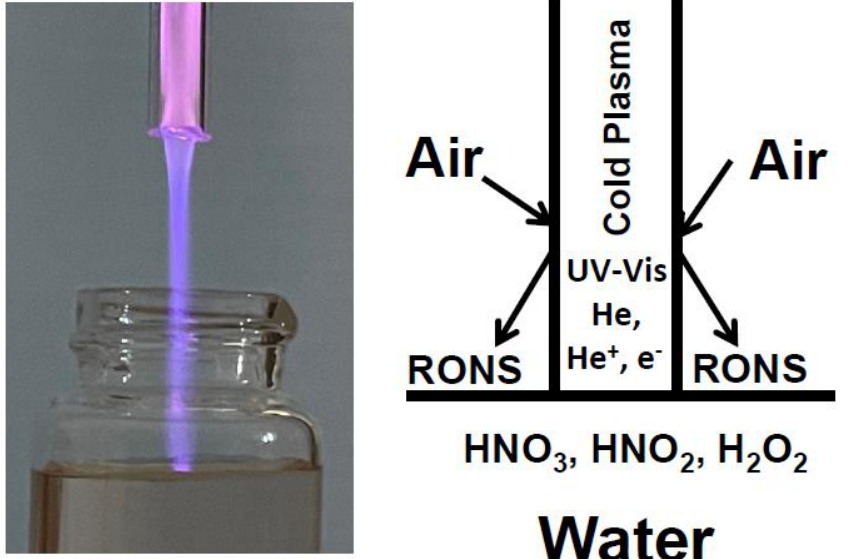
Figure 8. Plasma/water, plasma/air, and air/water interfaces. 20 mL clear borosilicate glass vials with magnetic stirrers were used in all experiments with CAPPJ treatments. The diameter of the water surface was 15 mm. The temperature was 20 °C .